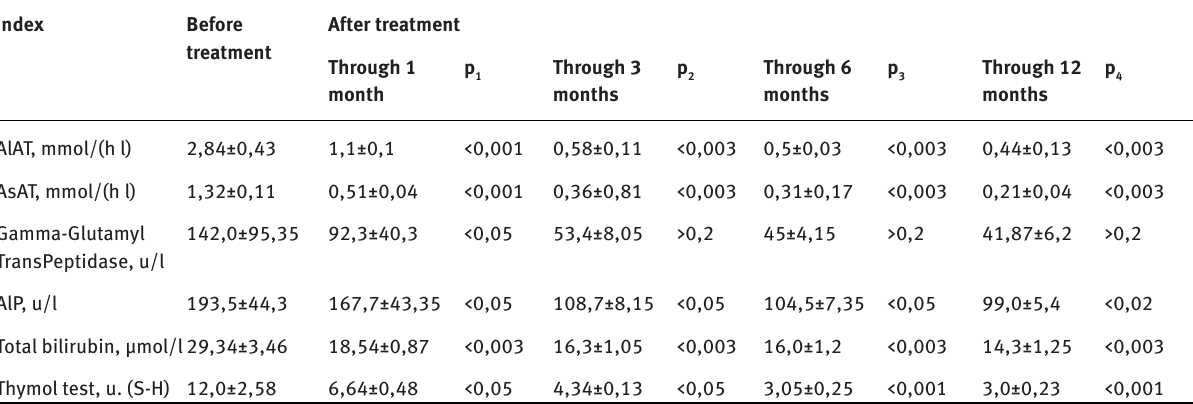
Table 2: Evolution of the functional status of the liver under influence of the standard antiviral therapy and resort (spa) treatments in pati- ents with chronic viral hepatitis C, (М±m), n = 31 (the basic